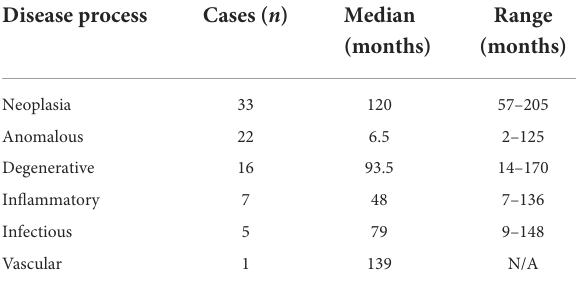
TABLE 2 Age at presentation for the different disease processes, presented in median and range